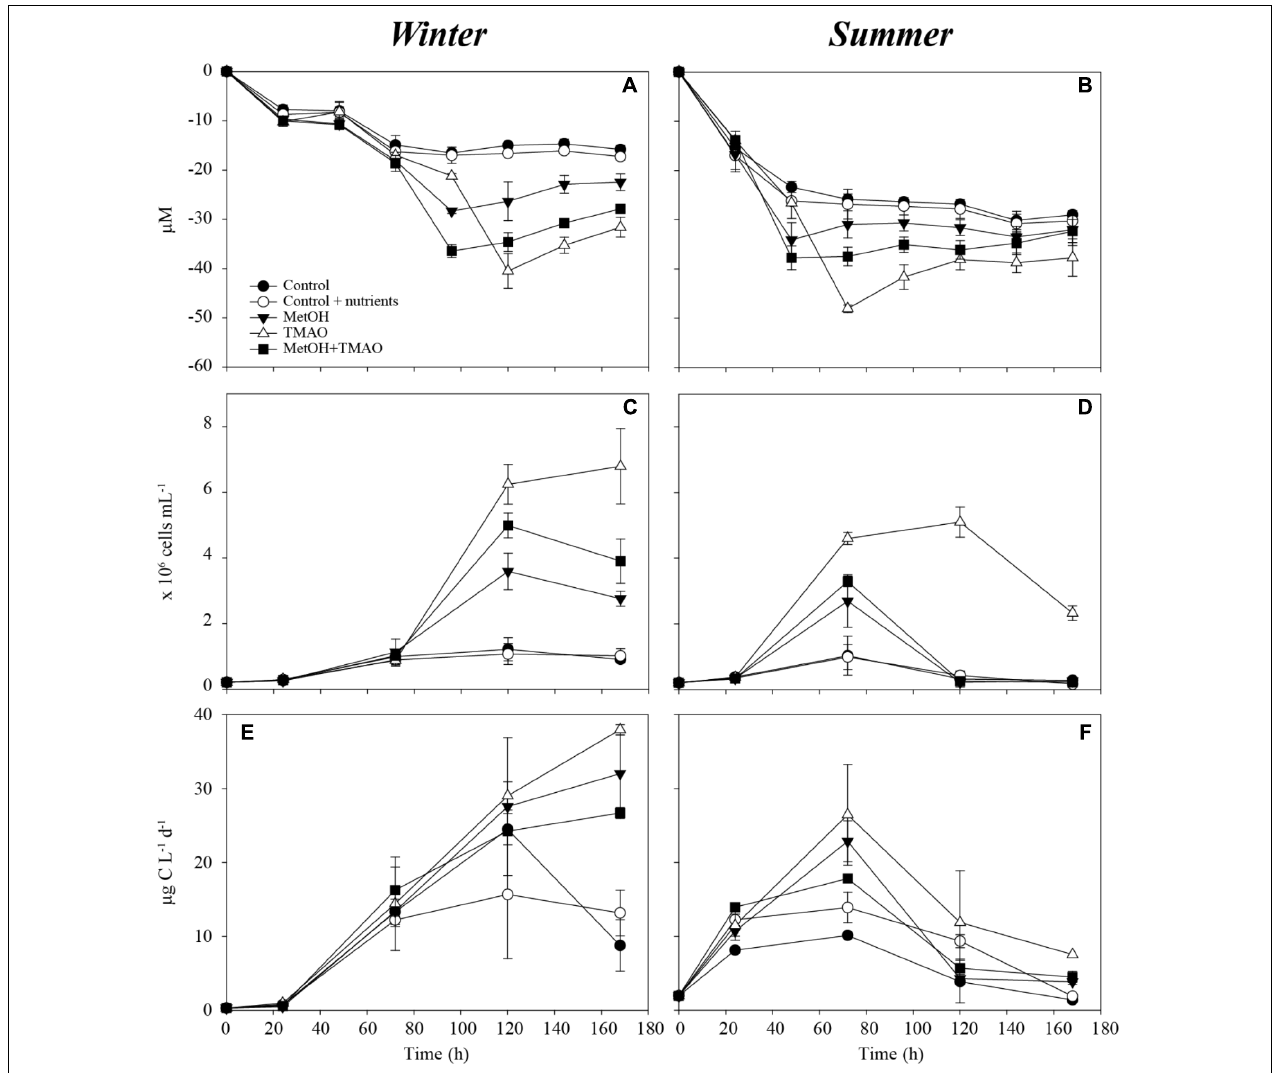
FIGURE 1 | Oxygen consumption over the course of the experiment in winter (A) and summer (B) , bacterial abundance over the course of the experiment in winter (C) and summer (D) and bacterial production over the course of the experiment in winter (E) and summer (F) . Mean ± standard deviation, n = 3.